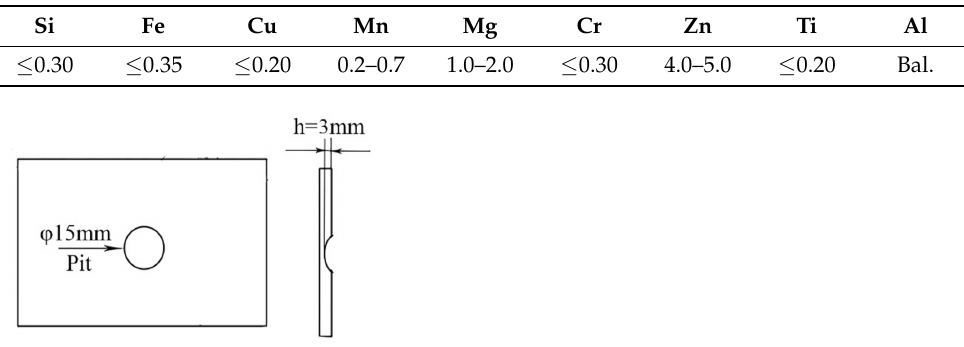
Figure 1. A schematic diagram of the samples with a factitious pit.